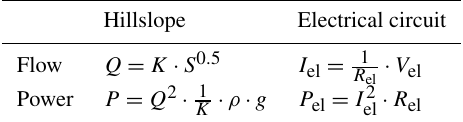
Table C1. Flow on hillslope equivalent to current in circuit.